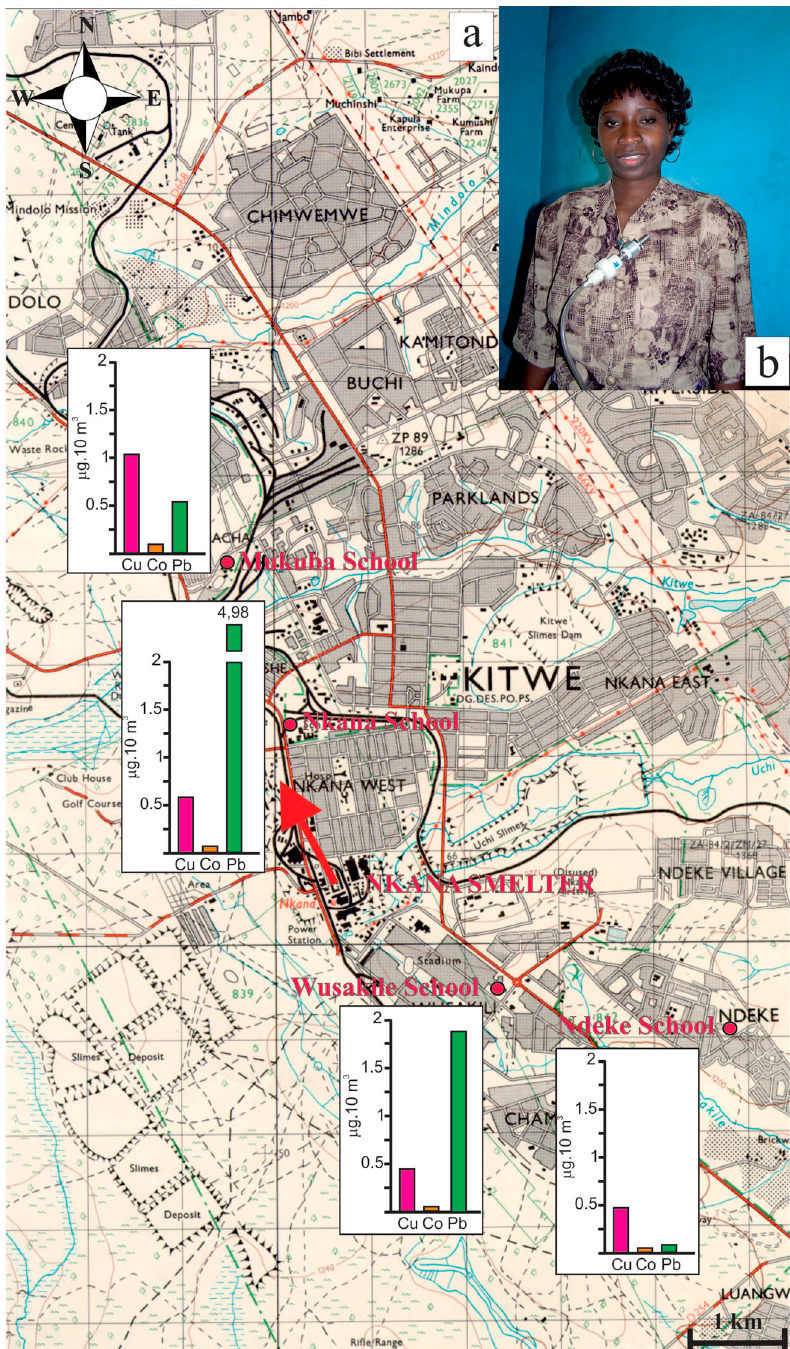
Figure 5. ( a ) Concentrations of Cu, Co, and Pb in ambient air in selected basic and high schools in Kitwe, Zambia. Red arrow indicates prevailing wind direction. ( b ) Voluntary collaborator in the particulate matter (PM) sampling, Ms. Jean Chokwe, Mukuba High School. The measurements were carried out at 8 h intervals. After K ř íbek and Nyambe [93].